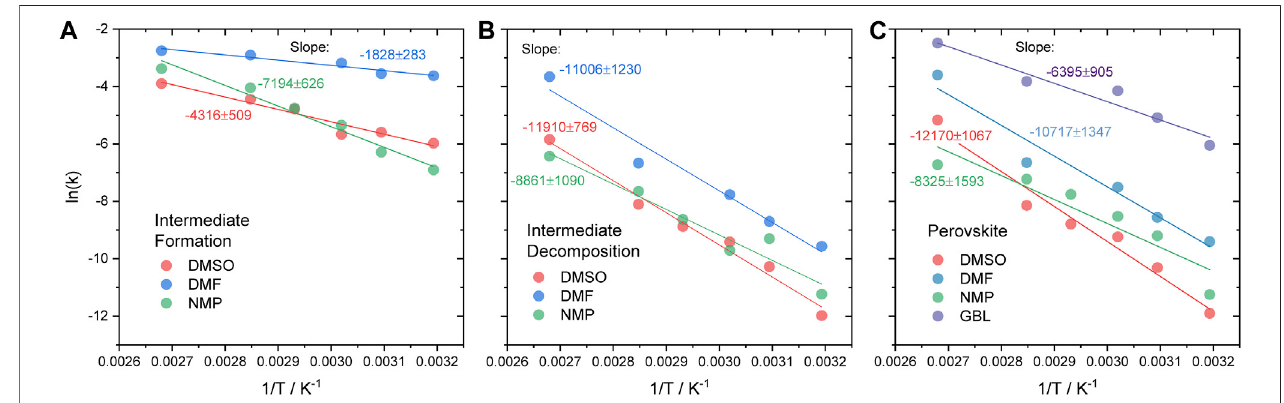
FIGURE 3 | Arrhenius plot of (A) intermediate phase formation and (B) decomposition and (C) perovskite phase formation from DMSO, DMF, NMP, and GBL.